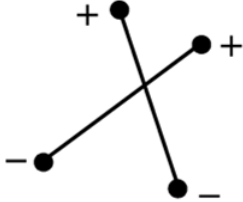
Figure 7. Sign differences between node-segment distances.